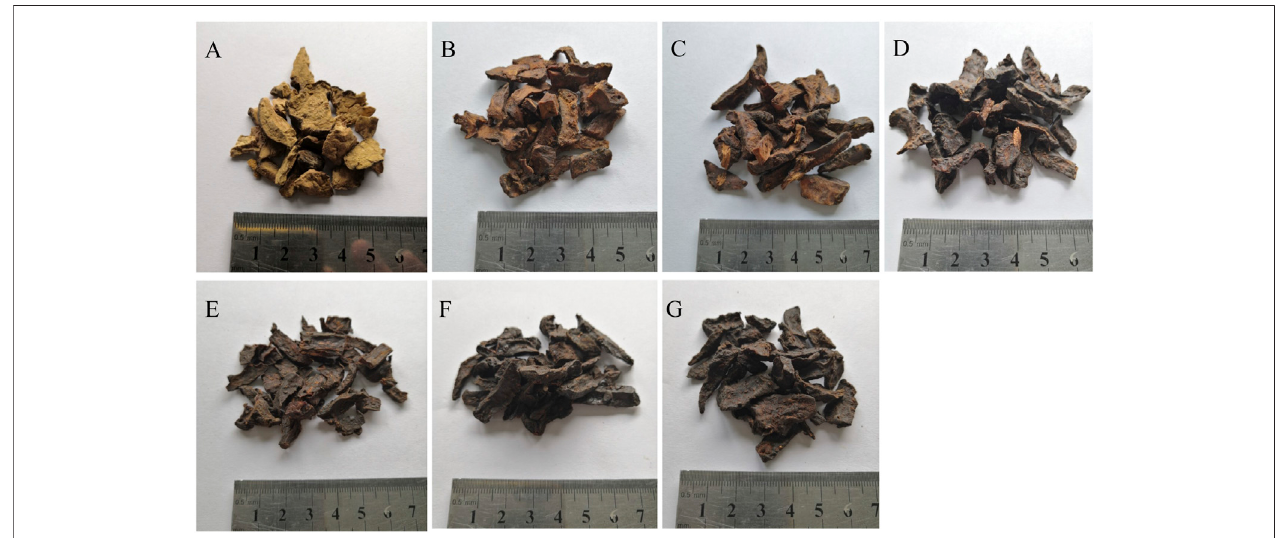
FIGURE1| Characters ofraw Reynoutria multi fl ora (RRM) and processed Reynoutria multi fl ora (PRM). ( (A) :RRM, (B) : PRM 4 h, (C) : PRM8 h, (D) :PRM 12 h, (E) : PRM 18 h, (F) : PRM 24 h, (G) : PRM 32 h). The appearance, section, and texture all change regularly.